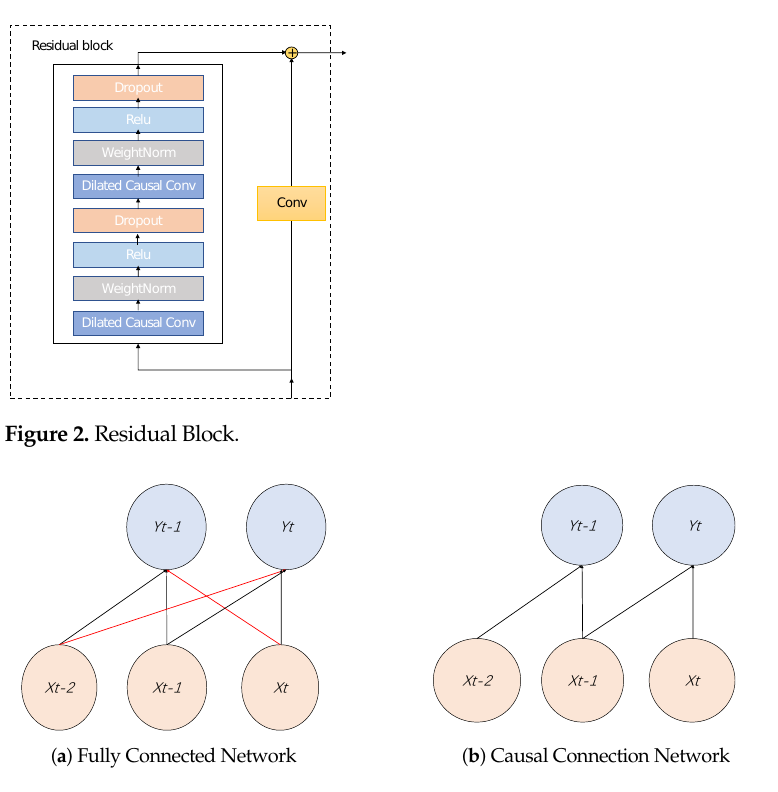
Figure 3. Two different types of network connections.